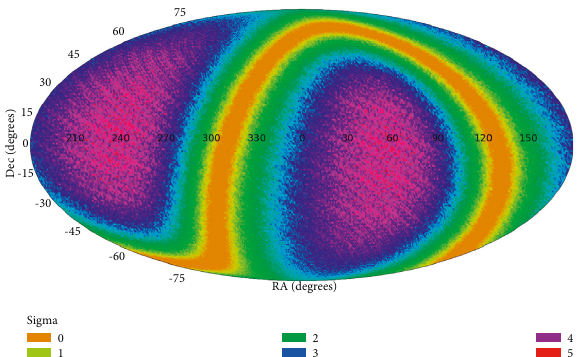
Figure 4: The probability of a dipole axis in galaxy spin directions from all different ( α , δ ) integer combination.